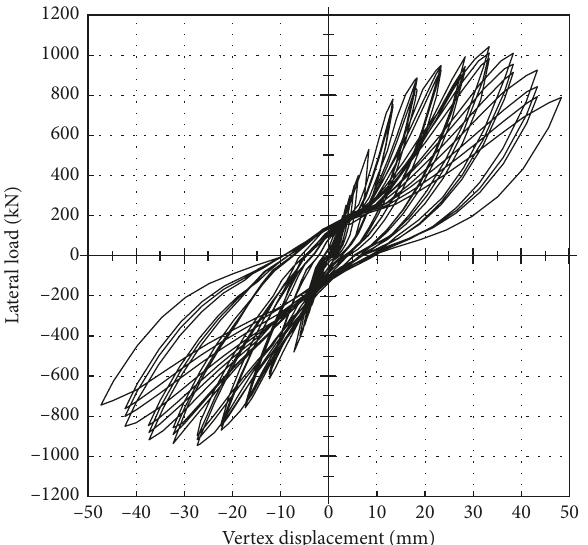
Figure 15: The force-displacement hysteretic curve.